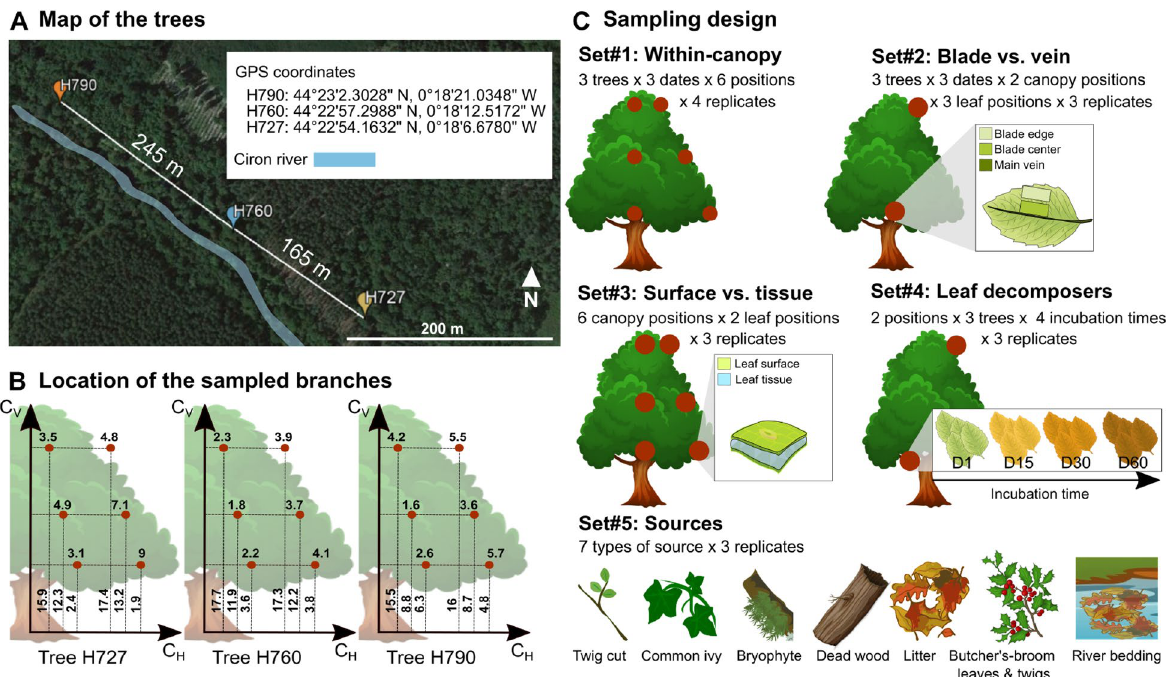
Fig. 1 Sampling design. A Map of the three European beech ( Fagus sylvatica ) trees sampled. B Position of the sampled branches in each tree. Horizontal values represent the distance to the trunk ( C H , in meters) and vertical values represent the height of the sampled branch ( C V , in meters). C Sampling design for each metabarcoding dataset (Set#1 to